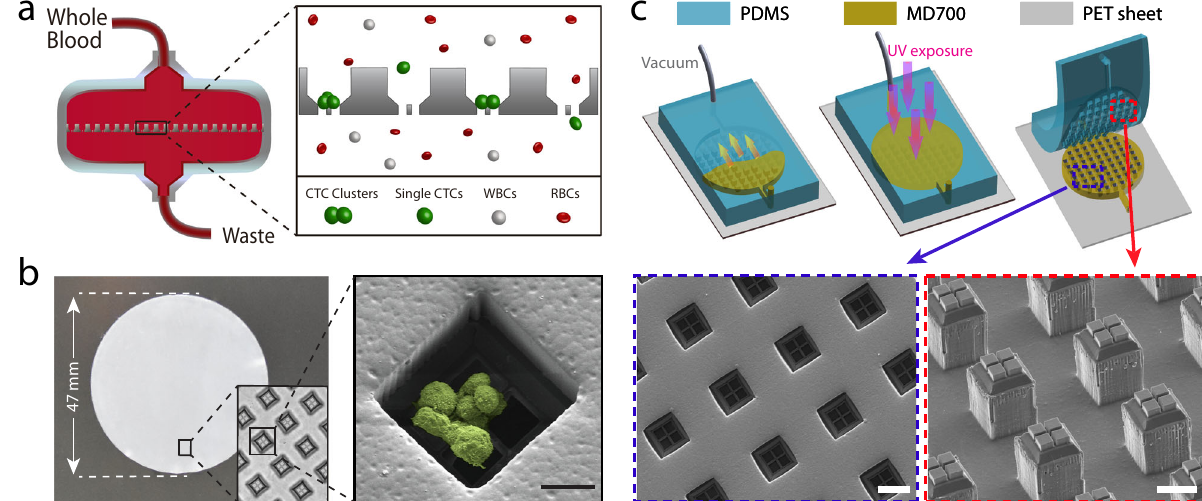
Fig. 1 Design and microfabrication of the Cluster-Wells. a Schematic illustration of the Cluster-Wells ’ working principle. While single cells pass unimpeded, the Cluster-Wells captures CTC clusters owing to their multicellular morphology from blood samples of cancer patients, independent of cancer type and their molecular character. b A photo of the Cluster-Wells manufactured in the form of a 47 mm-diameter membrane to be used in commercial fi lter holder. Close-up image (inset) shows individual wells designed to capture CTC clusters. (Right) Scanning electron micrograph of a blood-spiked LNCaP cluster as captured by one of the wells on the device (see “ Methods ” : SEM sample preparation and imaging). Scale bar, 20 μ m. c Schematic illustration of the fabrication process developed to mold polymer Cluster-Wells device. Steps shown in the fi gure exclude the fabrication process for the silicon mold and the construction of reusable PDMS mold, which can be found in Supplementary Figs. 2 and 3. Scanning electron micrographs of the PDMS structure employed for micromolding (lower right) and the fi nished device fabricated out of photocurable polymer, MD700 (lower left). Scale bars, 50 μ